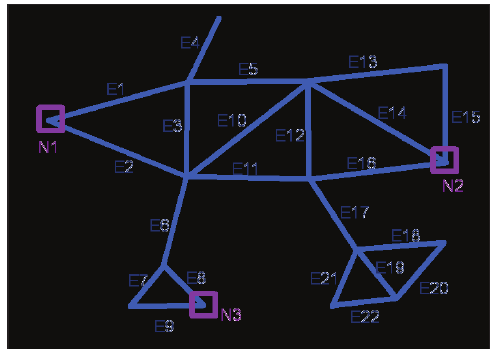
Fig. 3. Fragment of analyzed graph: N – flow